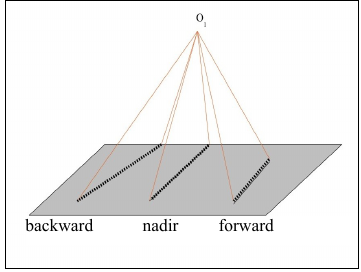
Figure 2. Three-line scanner scheme (axonometric projection)